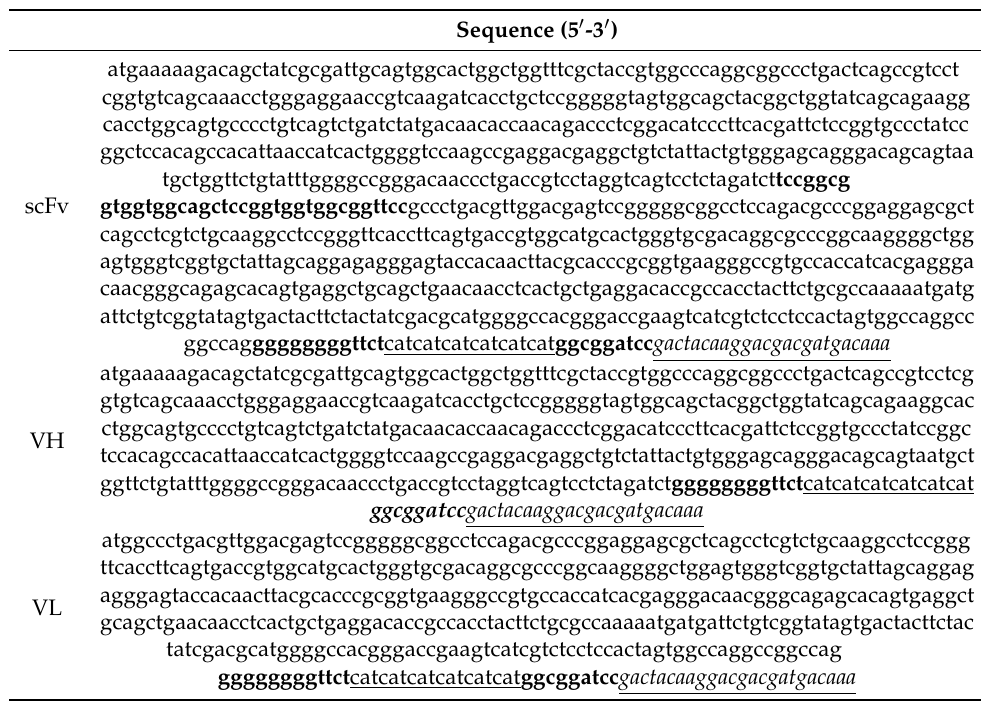
Table 2. Nucleotide sequences of anti-PDL1 scFv, anti-PDL1 VH, and anti-PDL1 VL with tags. Bold: linker, underline: His-tag, underlined italic: